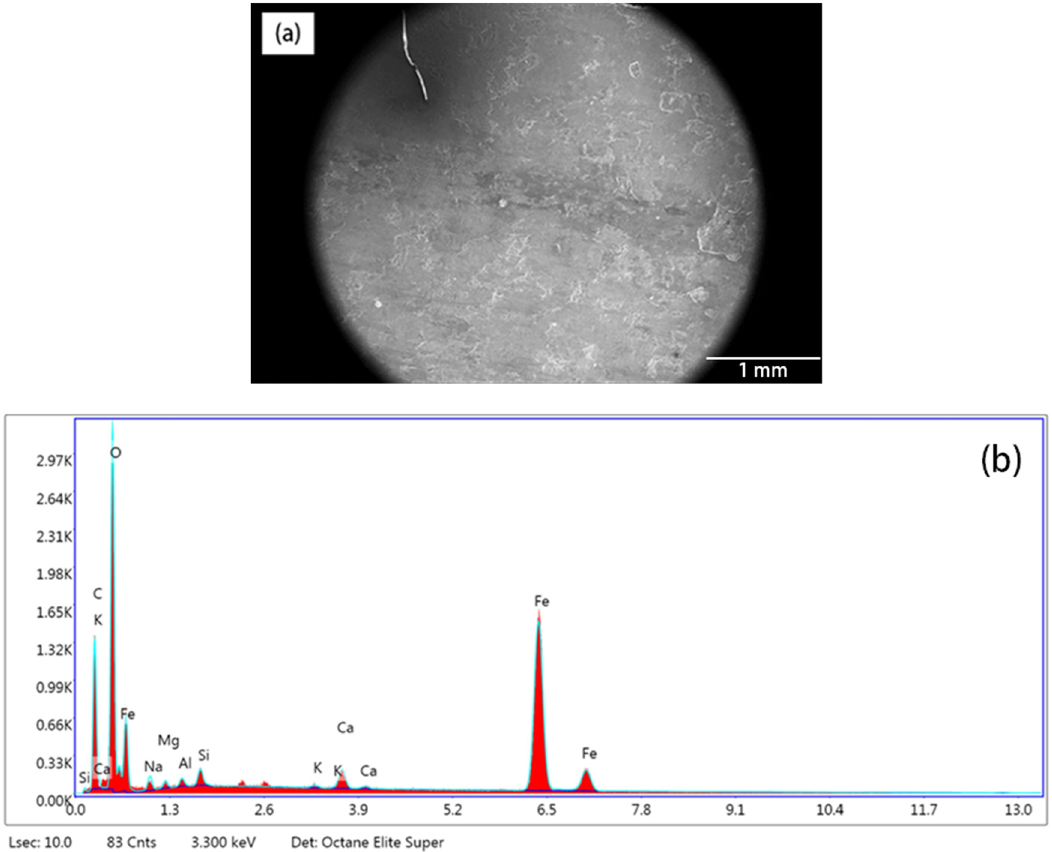
Figure 22: S - 3400N scanning electron microscope detection results: ( a ) morphology and ( b )